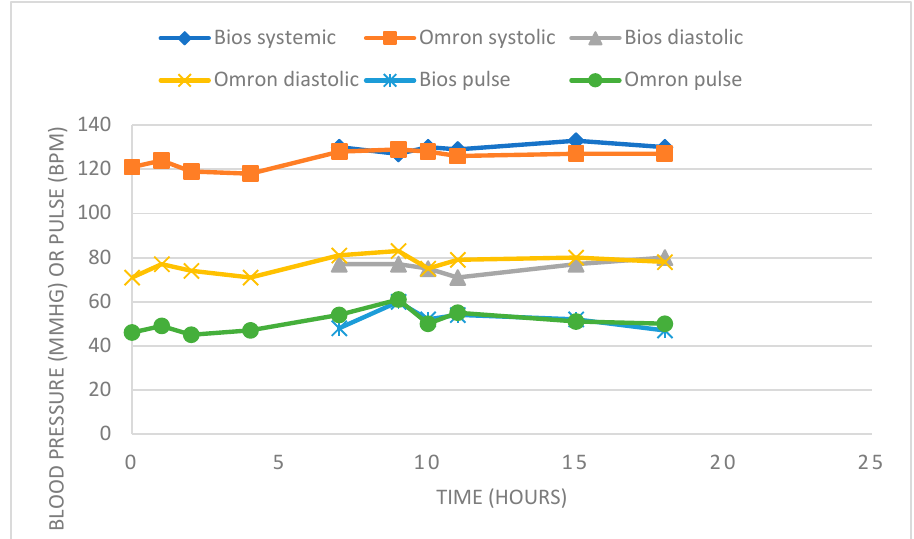
Figure 3. Night and daytime blood pressure measurements beginning at 3 am using two different devices (Bios and Omron).